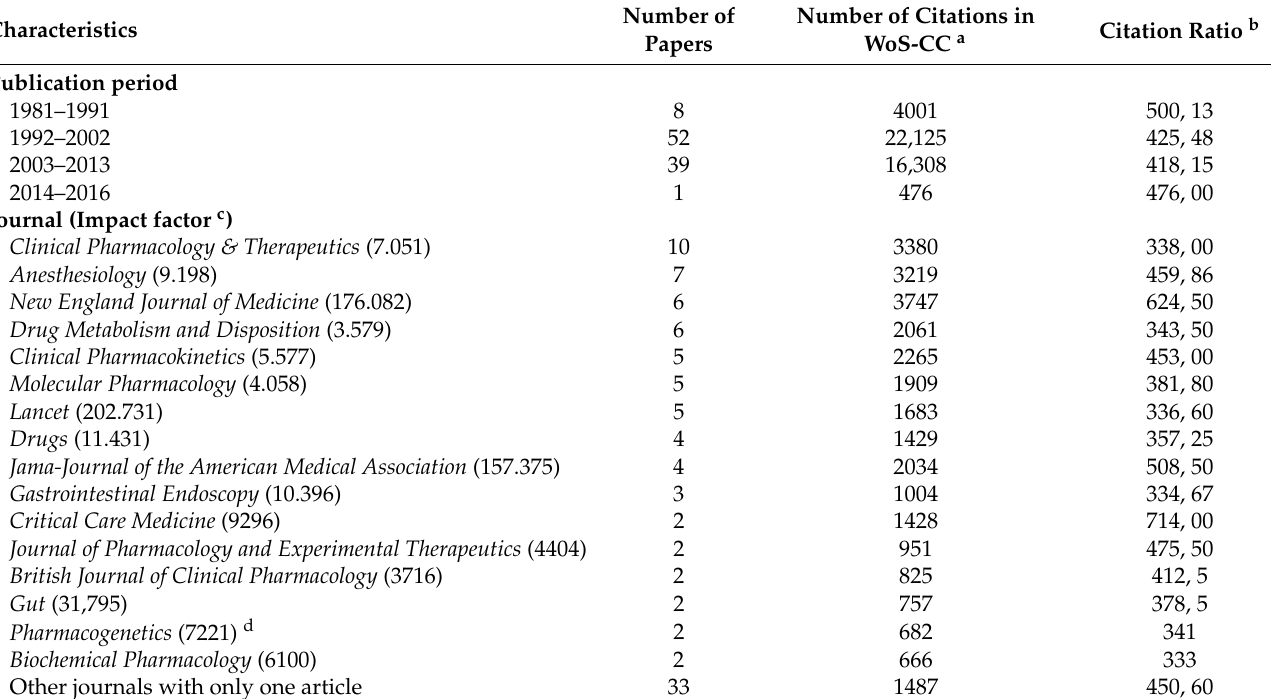
Table 2. Characteristics of the 100 most-cited studies about